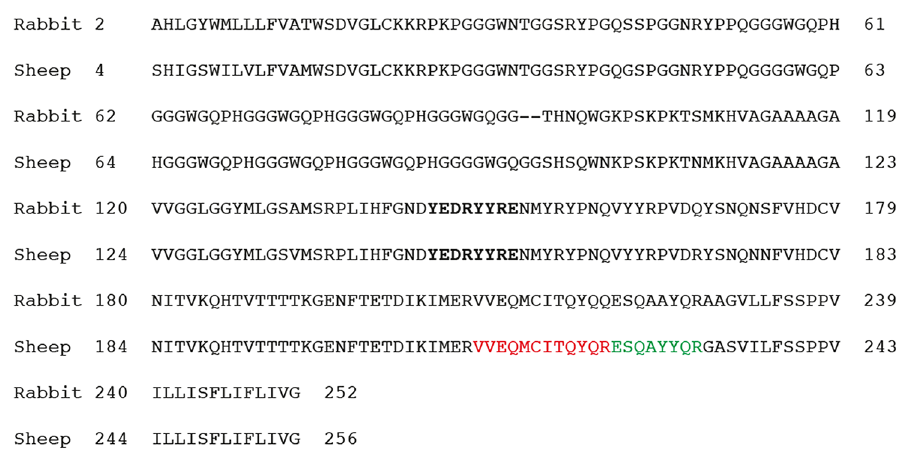
Fig 1. PrP amino acid sequences from New Zealand White rabbit and the sheep (VRQ allele). Fragments identified by mass spectrometry in the brains of scrapie-diseased tgOv rabbit and specific of the sheep sequence are colored. Bold: Sha31 anti-PrP